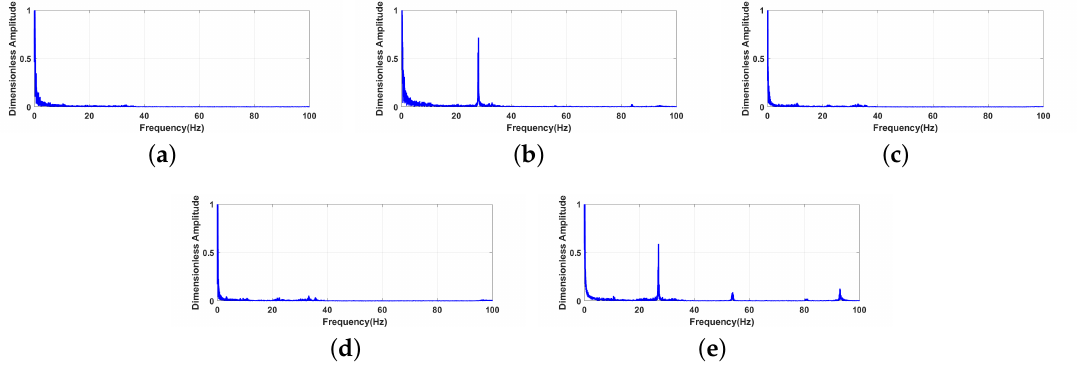
Figure 15. Single-sided dimensionless amplitude spectrum of the relative angular velocity. ( a ) Group A; ( b ) Group B; ( c ) Group C; ( d ) Group D; ( e ) Group E.